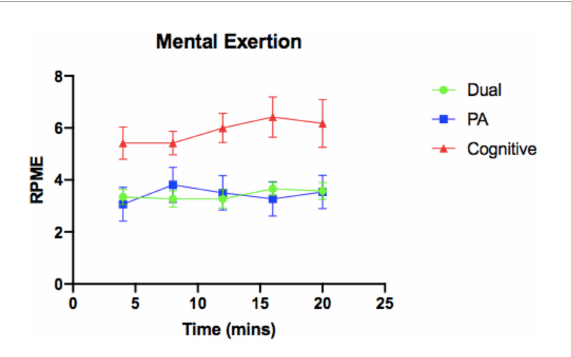
FIGURE2 Mental exertion over 20-min intervention. RPME, Ratings of Perceived Mental Exertion; PA, physical